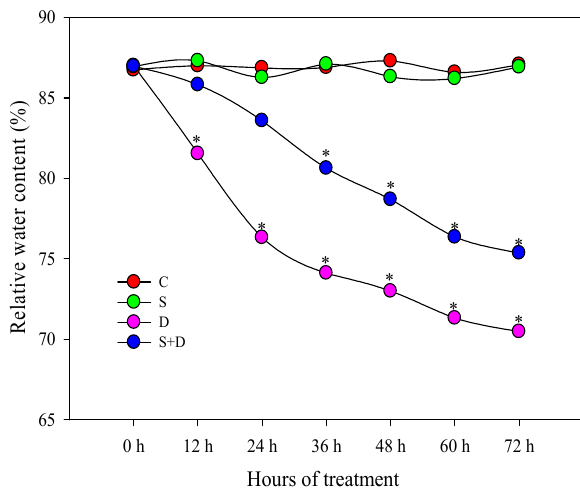
Figure 1. Change of relative water content (RWC) in leaves of wheat seedlings under normal water conditions and in response to three different treatments at different time points; a total of three independent biological replicates were conducted ( n = 10). C, normal water conditions; S, pretreated with 150 µmol/L sodium nitroprusside; D, water deficiency induced by 20% polyethylene glycol (PEG)-6000; S + D, pretreated with 150 µmol/L sodium nitroprusside and water deficiency stress by 20% PEG-6000. Asterisks indicate significant differences among the four treatments at p < 0.05.